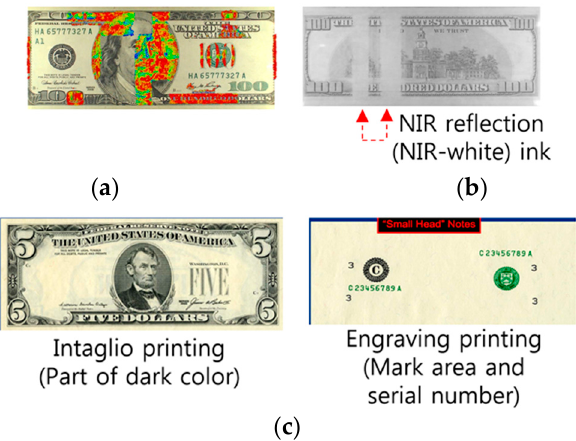
Figure 11. USD anti-counterfeiting features (magnetic factor, IR factor, and printing technology): ( a ) Magnetic factor for counterfeit prevention; ( b ) NIR factor for counterfeit prevention; ( c ) Printing scheme for a genuine banknote USD.